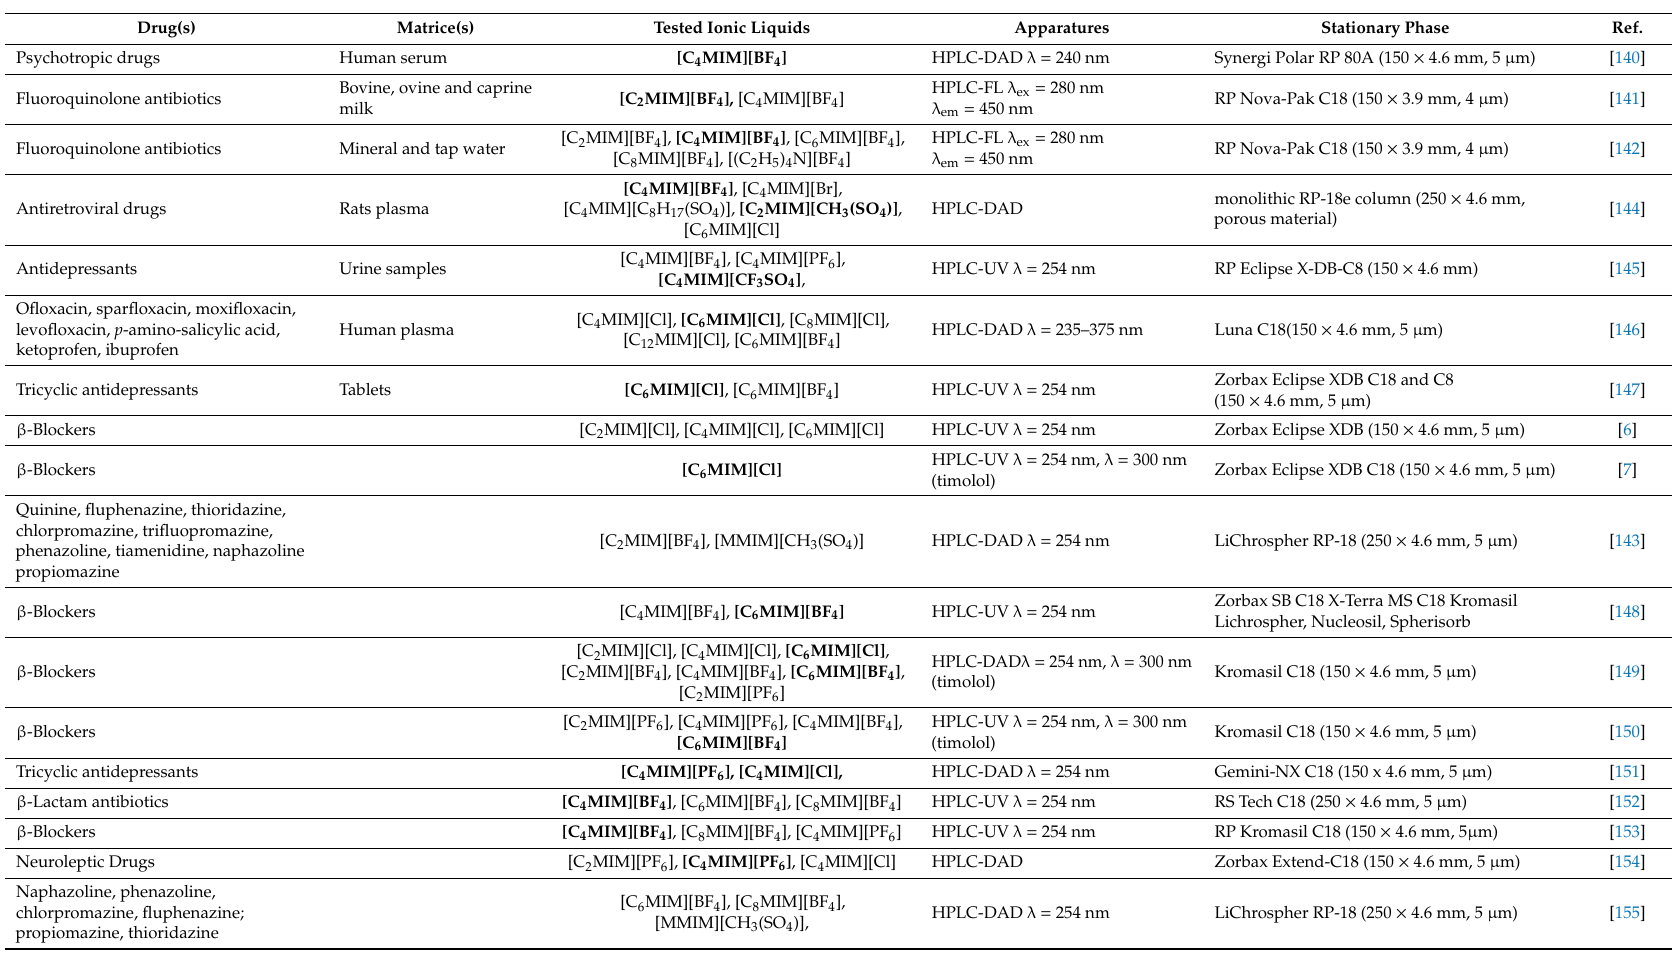
Table 3. Summary of the HPLC methods for the determination of pharmaceuticals in biological and environmental samples supported by the addition of ILs to the mobile